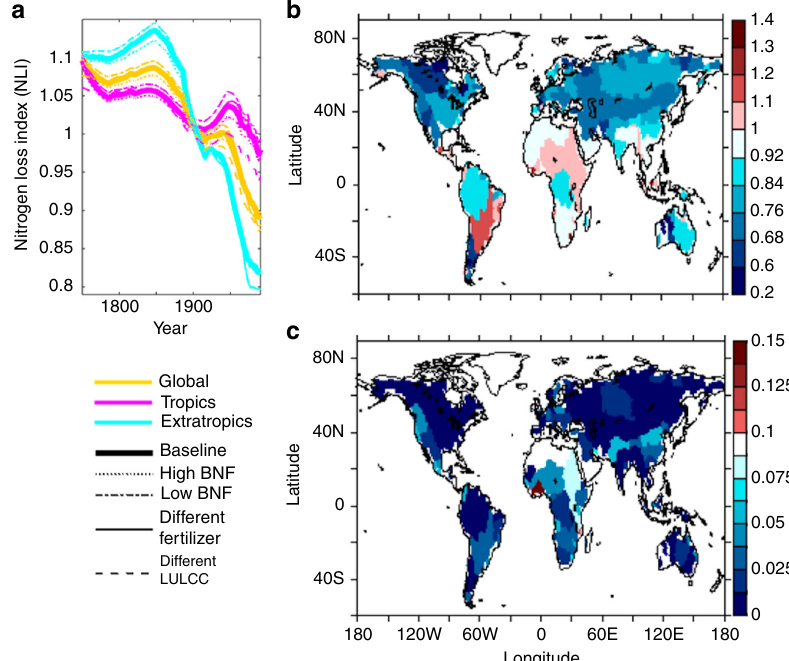
Fig. 3 N-Loss Index (NLI). a Global (yellow), tropical (magenta), and extratropical (cyan) NLIs. The thick line shows the baseline simulation. The thin lines show results forced by different inputs: dot (high BNF), dash-dot (low BNF), solid (Lu and Tian ’ s fertilizer 40 ), and dash (LULCC scenario without shifting cultivation 15 ). Globally, the baseline simulation produces 128 TgN yr − 1 of BNF (medium) during 1991 – 2005 that is between 116 TgN yr − 1 (low) and 145 TgN yr − 1 (high) (Supplementary Table 1 and Supplementary Note 1). The low BNF is close to an estimate by Green and colleagues 9 (112 TgN yr − 1 ) and